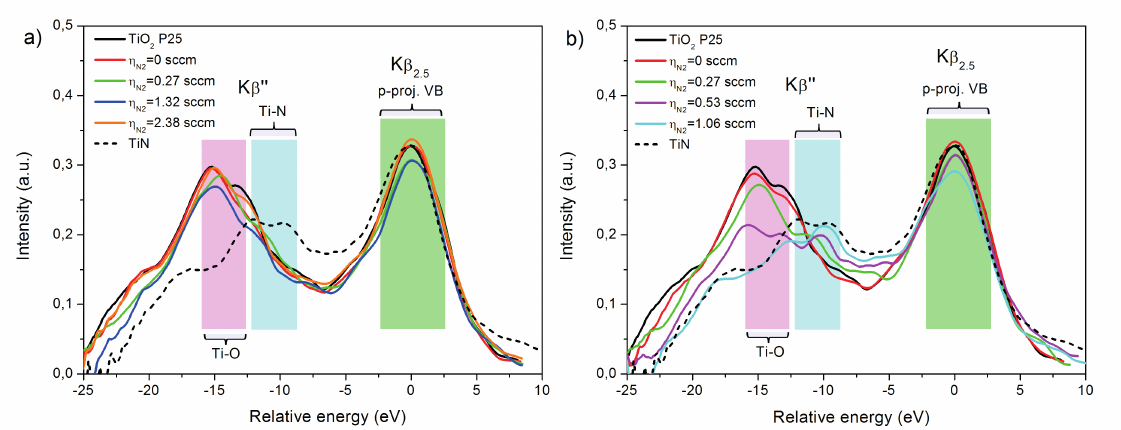
:N (I/I =0.13) and b) non-stoichiometric 2 0